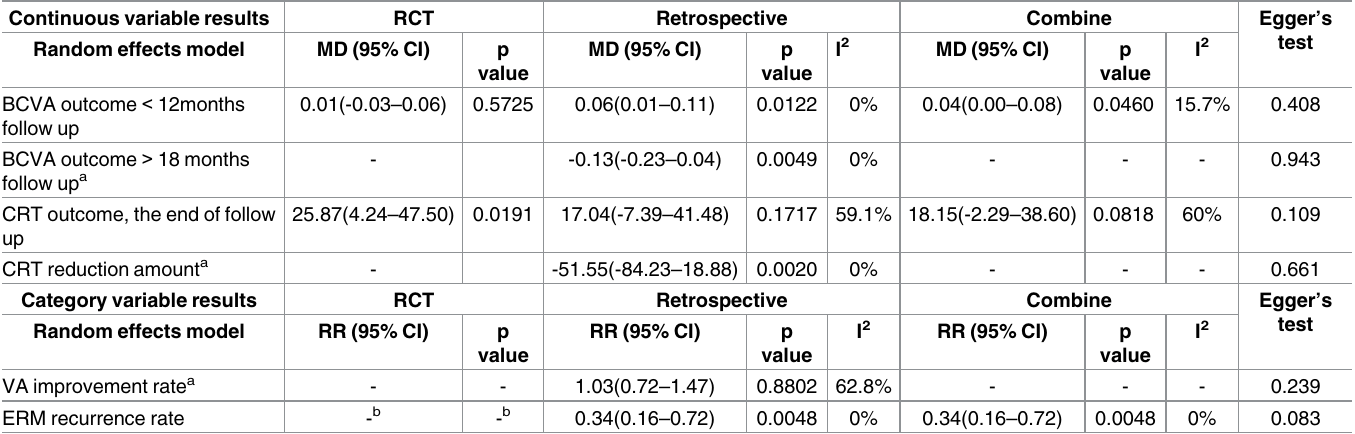
Table 4. Summaryof